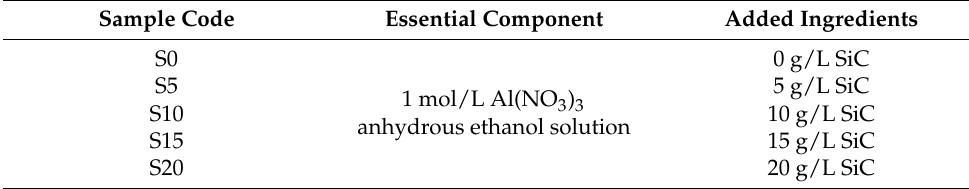
Table 2. Electrolyte